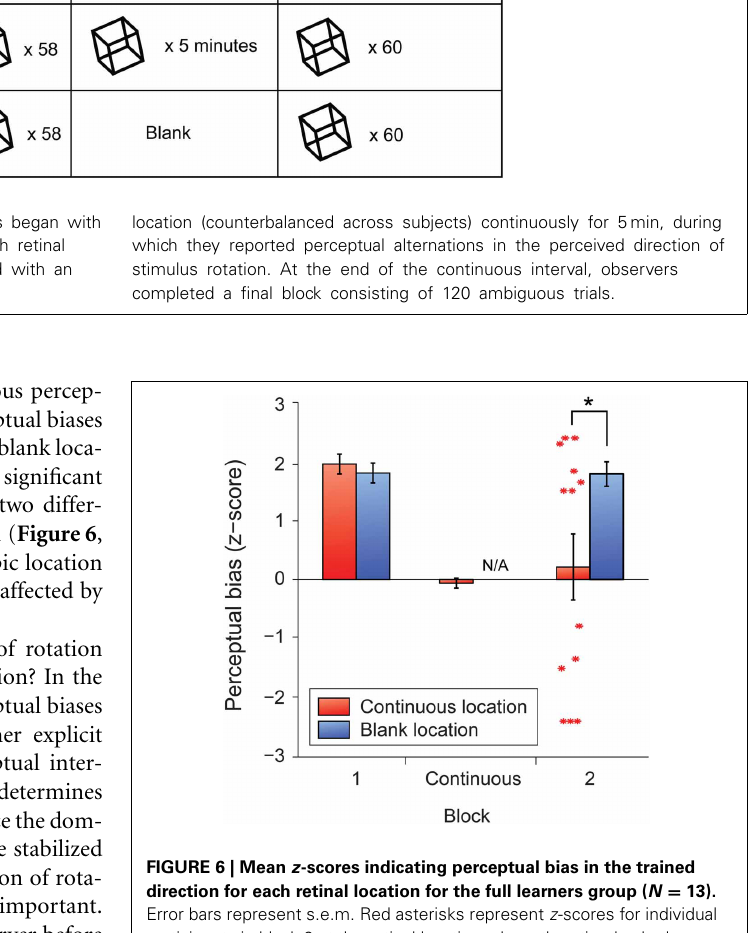
FIGURE 6 | Mean z -scores indicating perceptual bias in the trained direction for each retinal location for the full learners group ( N = 13). Error bars represent s.e.m. Red asterisks represent z -scores for individual participants in block 2 at the retinal location where the stimulus had previously been presented continuously. The black asterisk indicates a significant difference between means ( p < 0 .